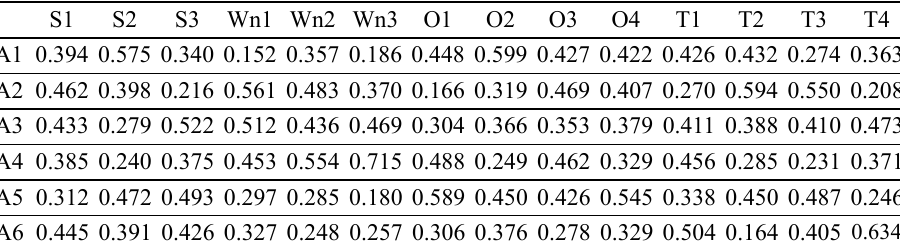
Table 11. the normalized decision matrix